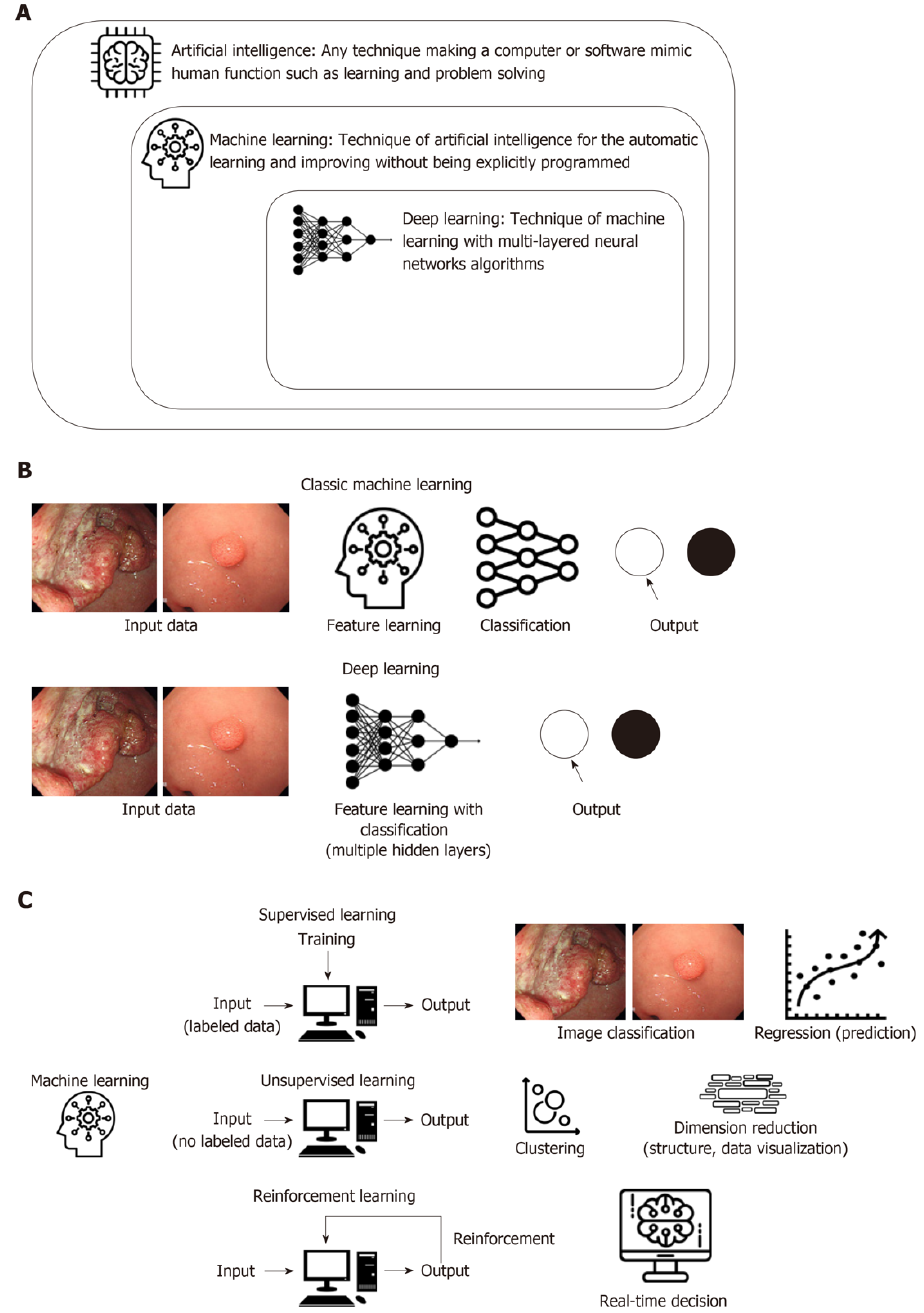
Figure 2. Representation of the processing methods of di ff erent types of artificial intelligence